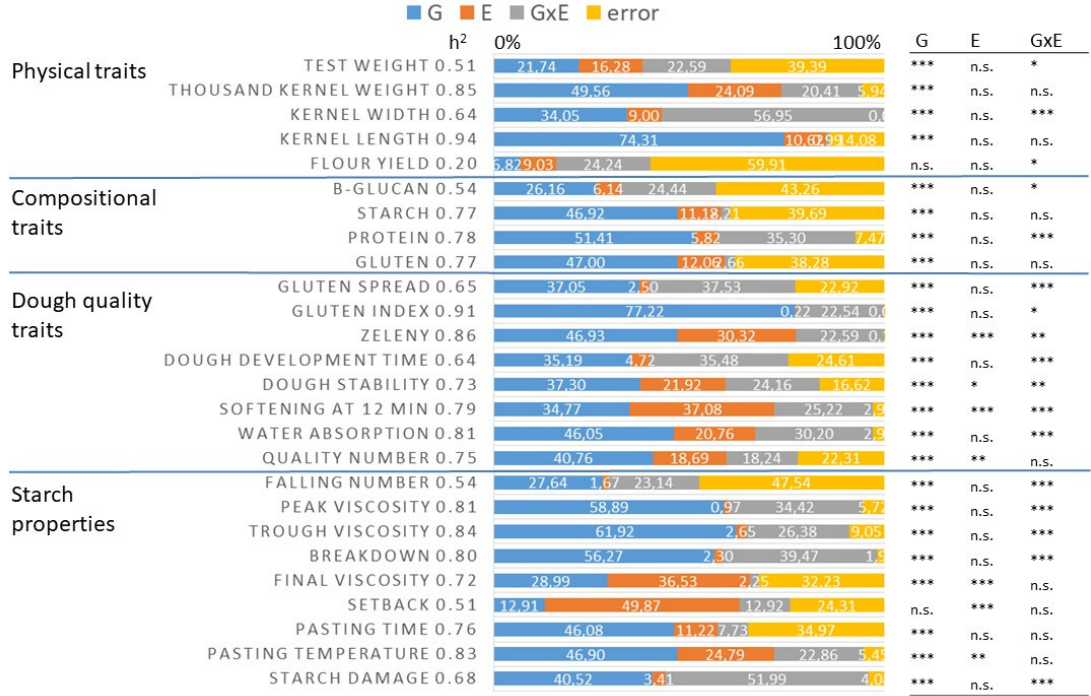
Figure 1. The relative contribution of genotype (G), environment (E-3 years), and genotype × environment interaction (G × E) for the total sum of squares to the physical, compositional, and breadmaking quality traits of spelt wheat and the broad-sense heritability of each traits (Martonvásár, Hungary, 2017–2019, n = 270); n.s. = non-significant; *, **, and *** significant at 0.5, 0.1, or 0.01 probability levels.